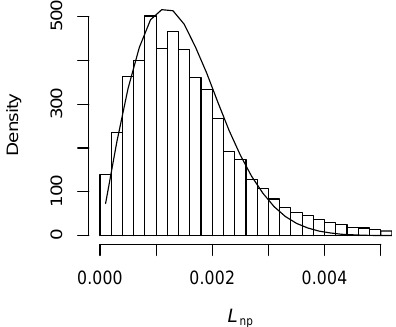
Figure 3. Histogram of observed normalized polarized radiance ( L np ) from the data in the rectangular box in Fig. 2. The solid line is the simulated error using a parametric bootstrapping method with s = 0 . 00095. The agreement is sufficient for estimating the noise level.